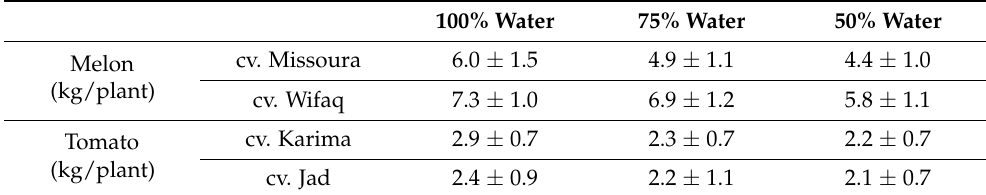
Table 2. Total yield (kg/plant) of melon and tomato crops grown under three strategies of irrigation (100%, 75% and 50%